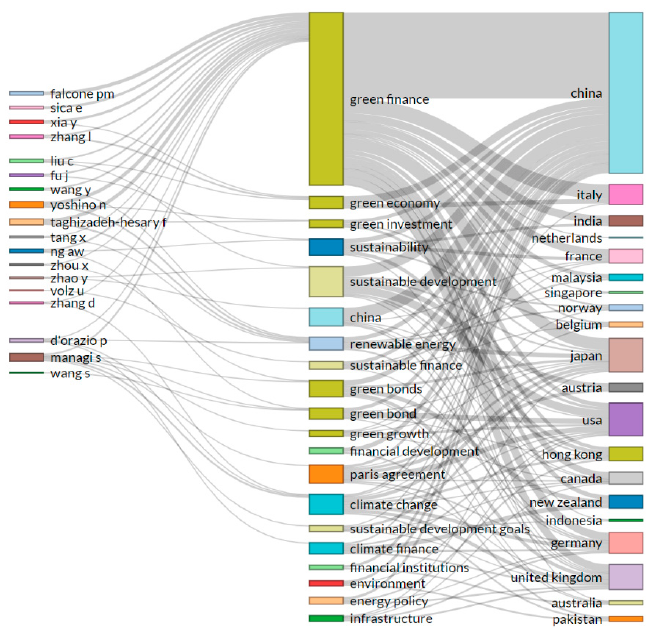
Figure 4. Three-field plot representing authors’ area of research (line 242).